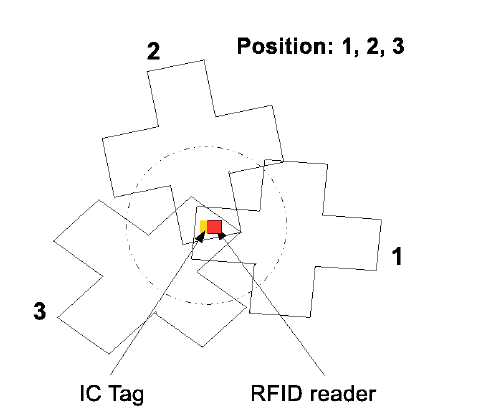
Figure 3. Possible poses of the robot when one reader detects a tag: Positions 1, 2 and 3 are possible poses of the robot when it detects the tag by means of its